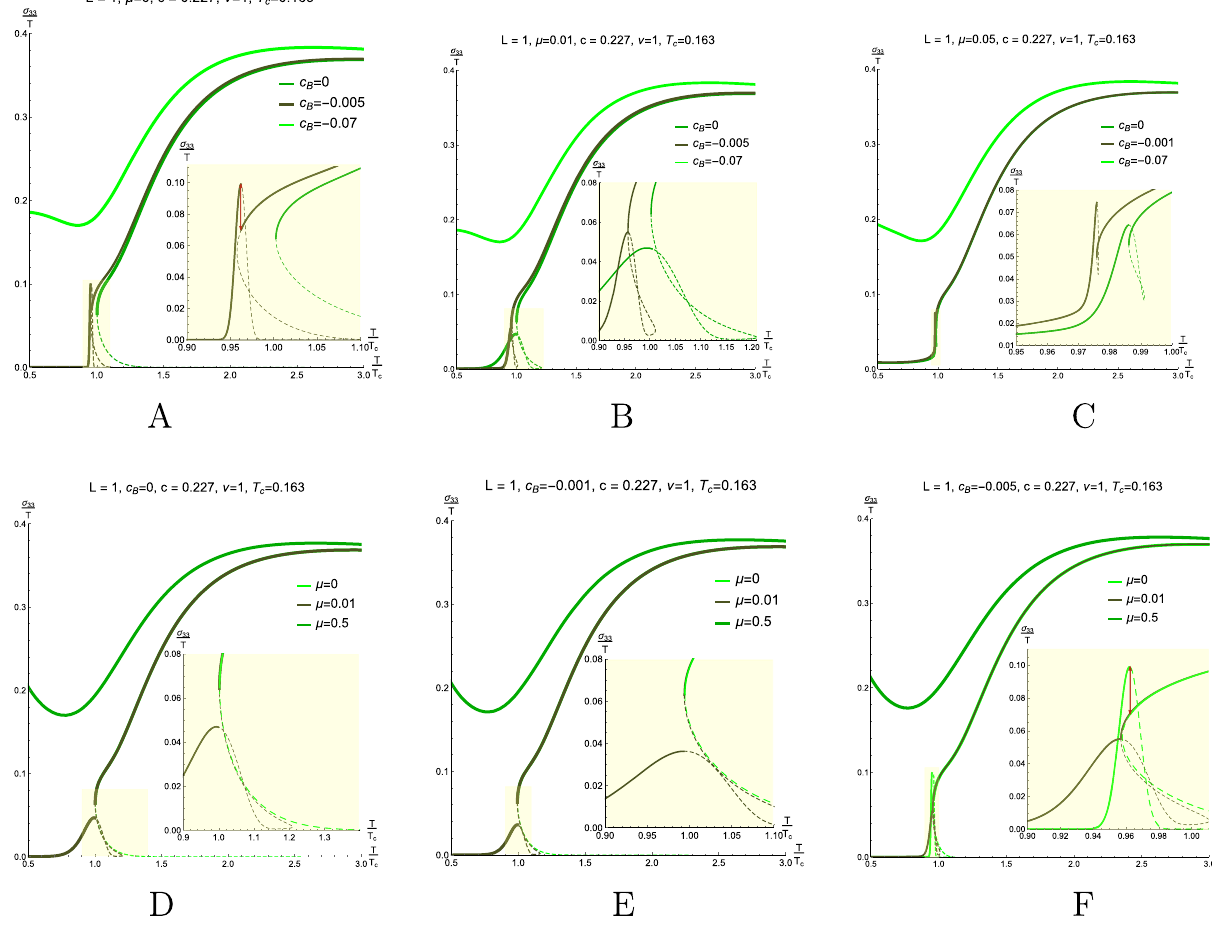
Fig. 9 Thedependenceof σ 33 / T onthenormalizedtemperature T / T c for different values of magnetic field’s parameter c B and μ = 0 ( A ), μ = 0 . 01 ( B ) and μ = 0 . 05 ( C ), and for different values of chemical potential μ and c B = 0 ( D ), c B = − 0 . 001 ( E ) and c B = − 0 . 005 ( F ).